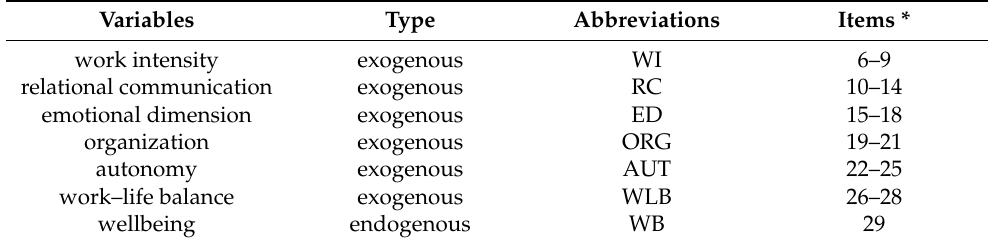
Table 1. The endogenous and exogenous